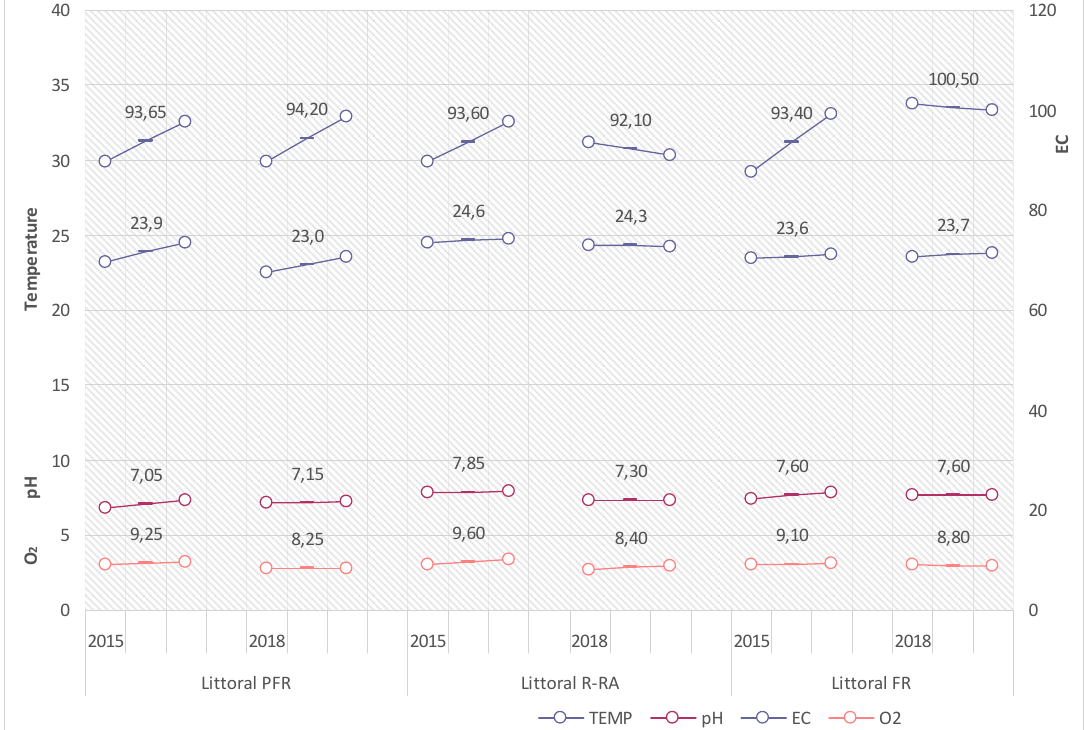
Figure 7. Mean values with ranges of physical-chemical properties of littoral waters of sectors of the Lake Piaseczno catchment in the 2015 and 2018 summer seasons: O 2 , oxygen concentration (mg O 2 ·dm − 3 ); temperature (°C); EC, electrolytic conductivity ( μ S·cm − 1 ); pH, reaction.